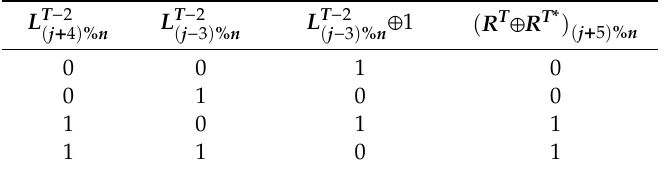
and ( R T ⊕ R T ∗ ) ( j + ( j + 4 ) % n